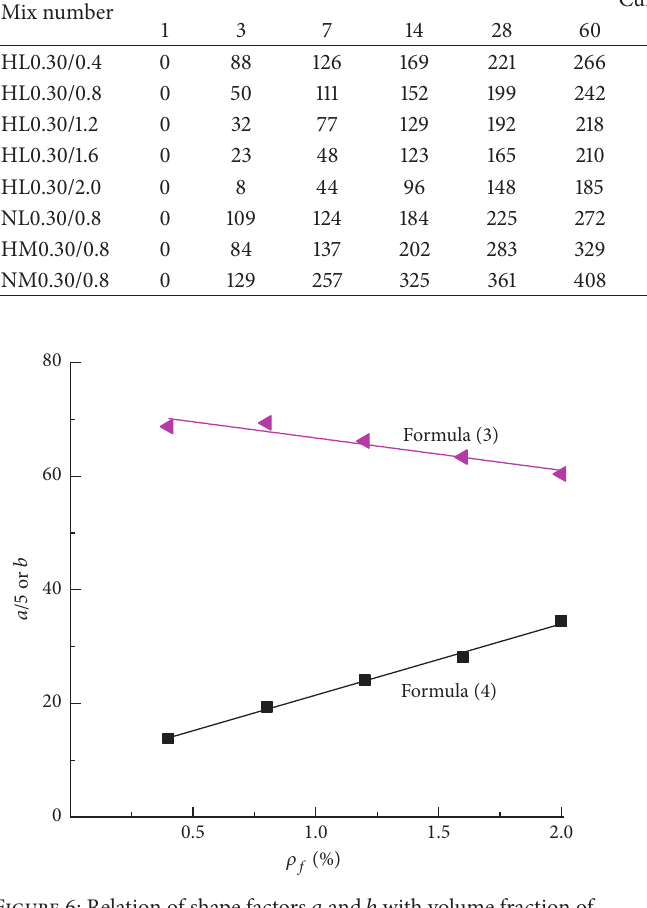
Figure 6: Relation of shape factors 𝑎 and 𝑏 with volume fraction of steel fiber.